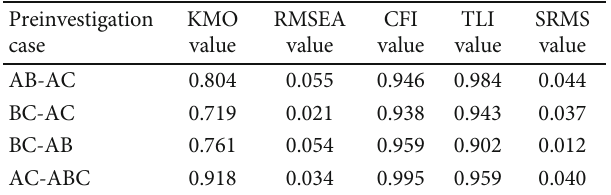
Table 1: Preinvestigation description of mitigation